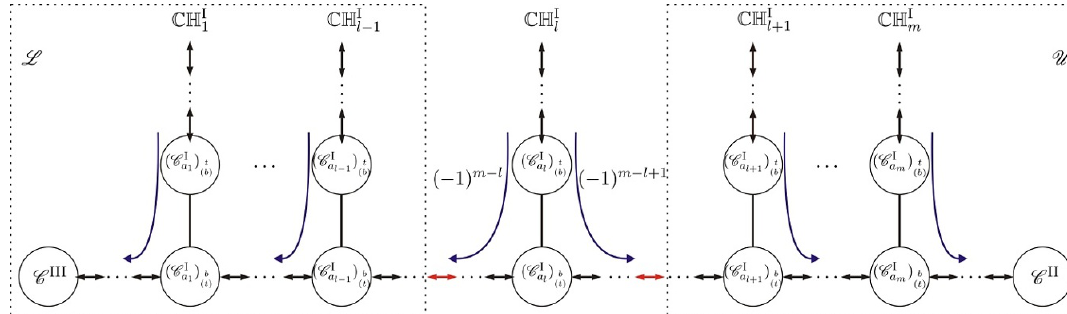
Figure 14 . A typical spurious graph. There are m spurious structures C I , . . . , C I on the path a 2 a m from the highest weight node h towards a root. The chains CH I , CH I , . . . , CH I ( CH I , (cid:26) ( s ) 1 2 l (cid:0) 1 l +1 CH I , . . . , CH I ) containing C I , C I , . . . , C I ( C I , C I , . . . , C I ) must belong to the (cid:12)nal l +2 m a 1 a 2 a l (cid:0) 1 a l +1 a l +2 a m lower (upper) block. The lowest-weight chain CH I among CH I ( i = 1 ; : : : ; m ) can belong to either l i the (cid:12)nal upper block (with sign ( (cid:0) 1) m (cid:0) l +1 ) or the (cid:12)nal lower one (with a sign ( (cid:0) 1) m (cid:0) l ). Thus two spurious graphs with the same con(cid:12)guration but opposite signs are obtained from two distinct con(cid:12)gurations of the (cid:12)nal upper and lower blocks,